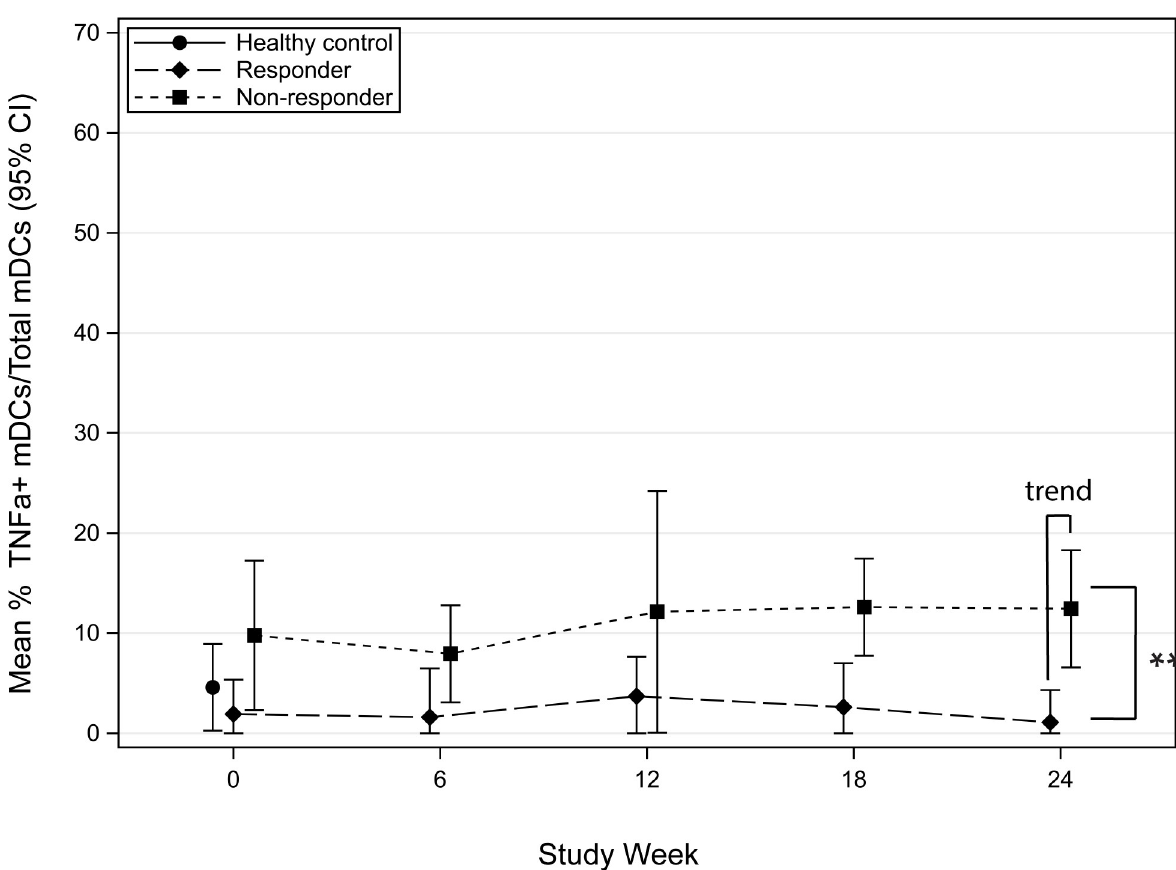
Fig 4. Mean percent frequency (95% CI) of TNFa-producing myeloid dendritic cells (mDCs) following CPE stimulation in POIT responders and non-responders in the first 24-weeks.